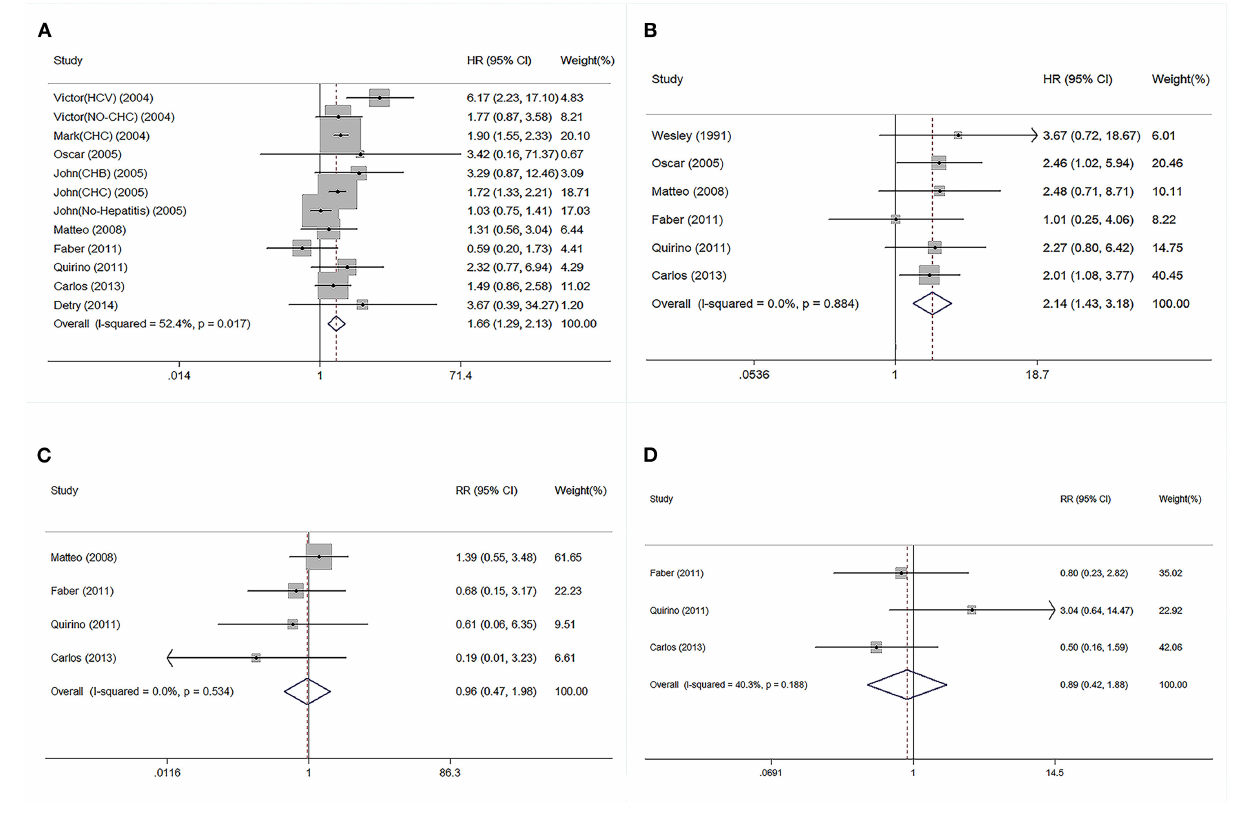
Frontiers in Medicine |